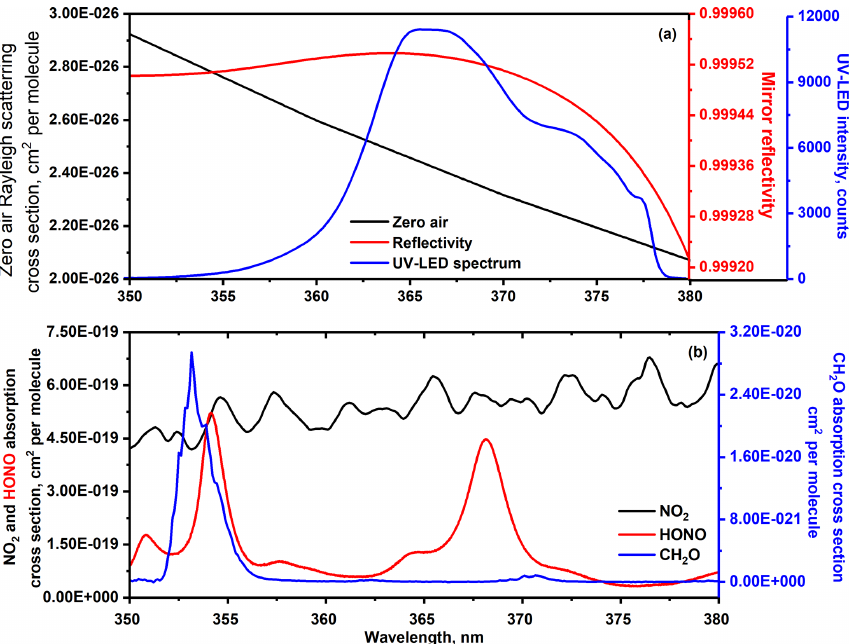
Figure 3. Spectral region of 350–380nm for IBBCEAS measurements: (a) UV-LED emission spectrum (blue), wavelength-dependent mirror reflectivity (red) and Rayleigh scattering cross section of zero air (black) (Miles et al., 2001); (b) NO 2 (black), HONO (red) and CH 2 O (blue) absorption cross